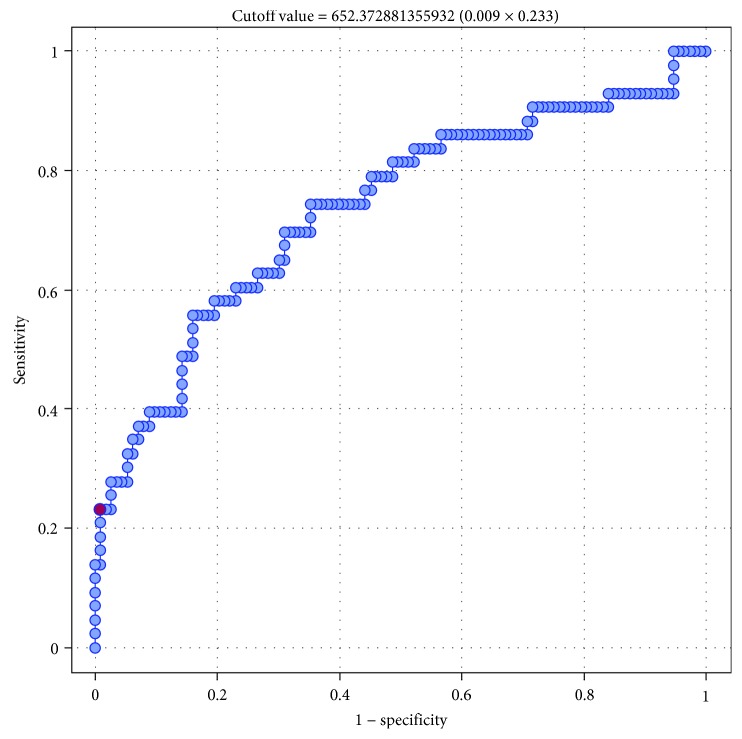
ROC curve—relationship between sFlt-1/25(OH)D index and occurrence of gestational hypertension (AUC 73.6%).